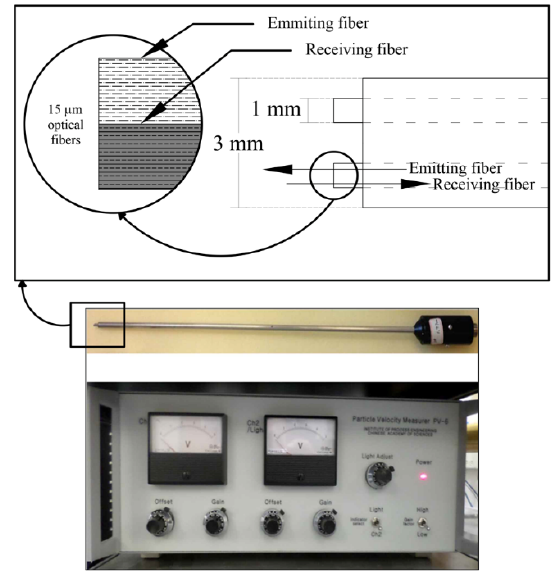
Figure 4. Details of the Two-Tip Optical Fiber Probe technique.